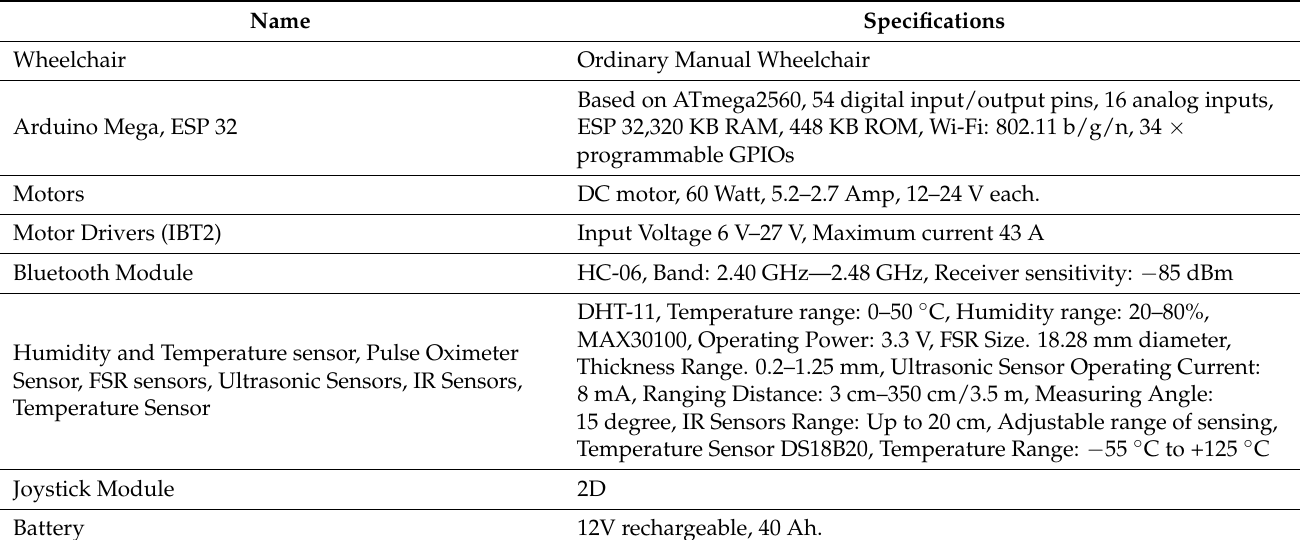
Table 2. Hardware and component